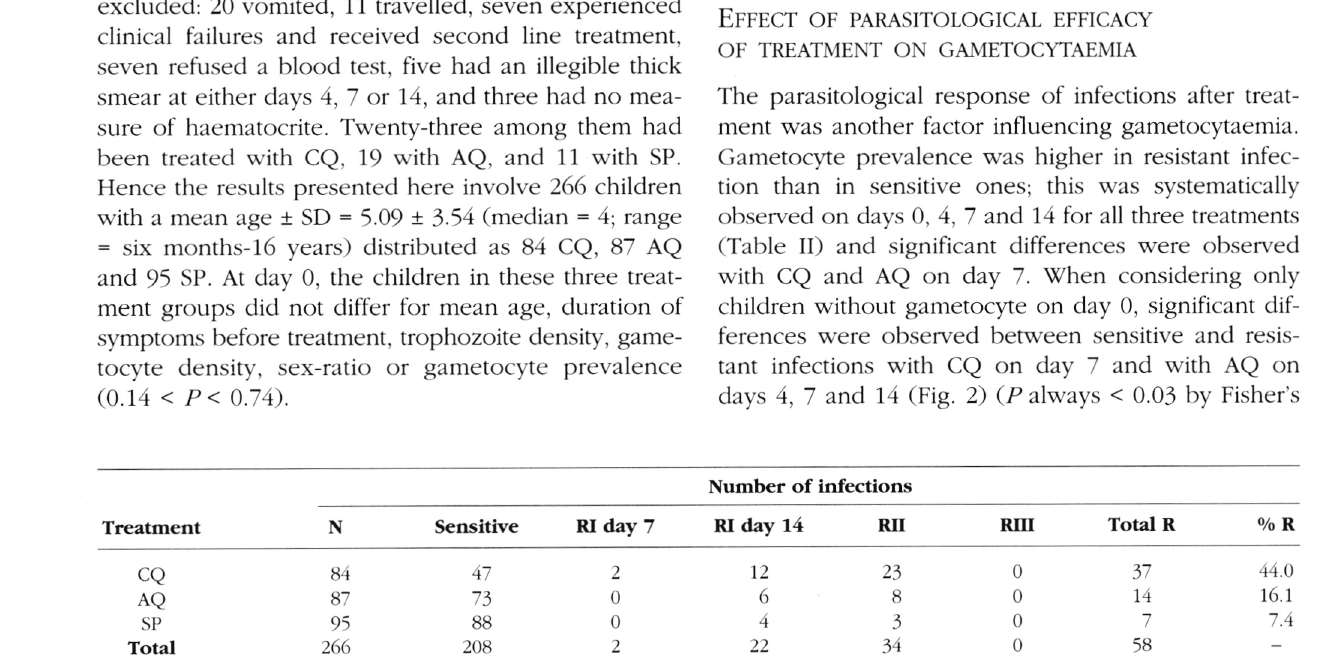
Table I. - Number of P. falciparum infections, according to treatments (CQ = chloroquine, AQ = amodiaquine, SP = sulfadoxine + pyri­ methamine) and to parasitological responses (R =